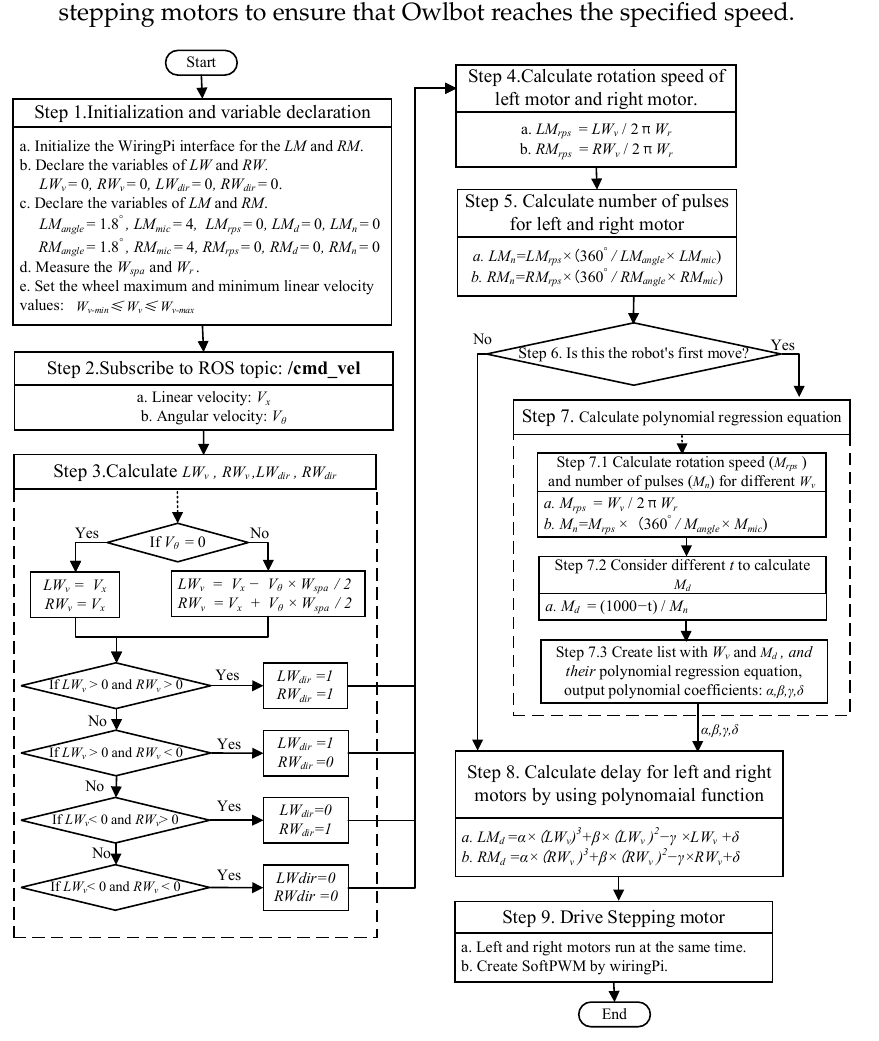
Figure 7. Process flow of the proposed stepping motor control algorithm based on the polynomial regression equation. Algorithm 1: Proposed stepping motor control algorithm